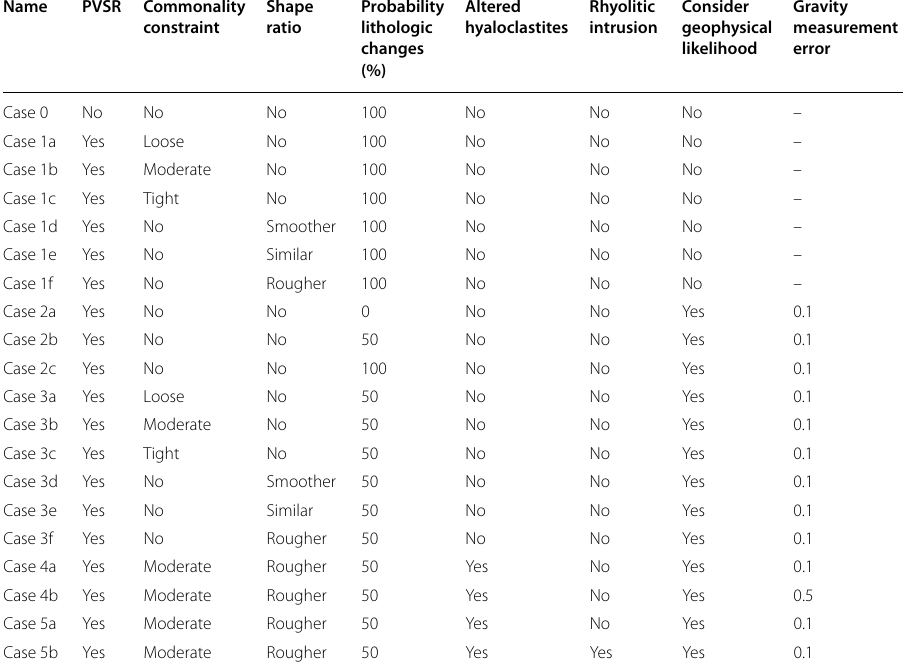
PVSR Preservation of vertical stratigraphic relationships from reference prior